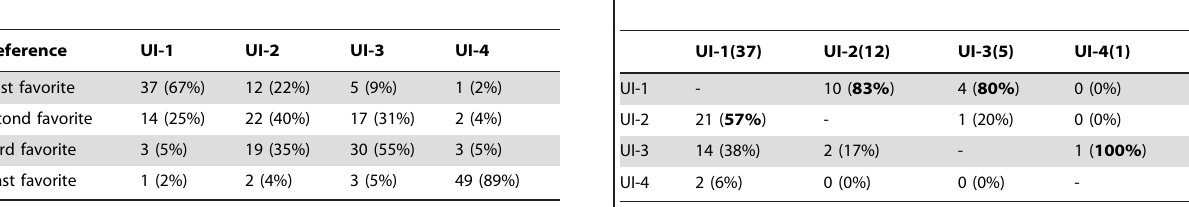
UI-1: Important figure + thumbnails, UI-2: Figure thumbnails only, UI-3: Important figure only, UI-4: Full text.